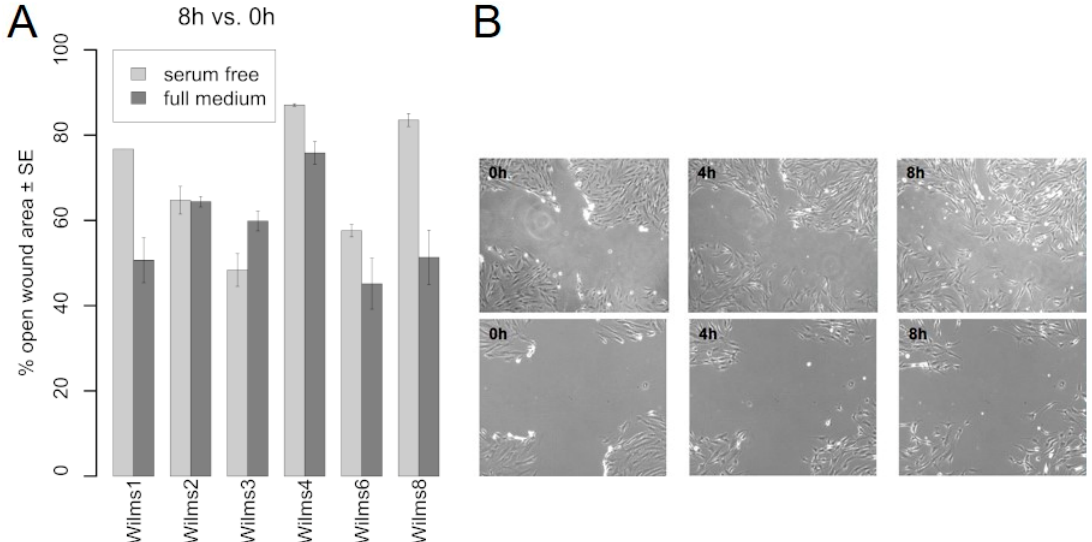
Figure 4. Migration properties of Wilms cell lines. ( A ) Migration of the indicated Wilms cell lines into the wound in serum free and full medium is shown. The percentage of open wound left after 8 h is indicated. ( B ) Example of Wilms8 cell growth in the wound in full medium, top panel and serum free medium, lower panel. Magnification 20×.